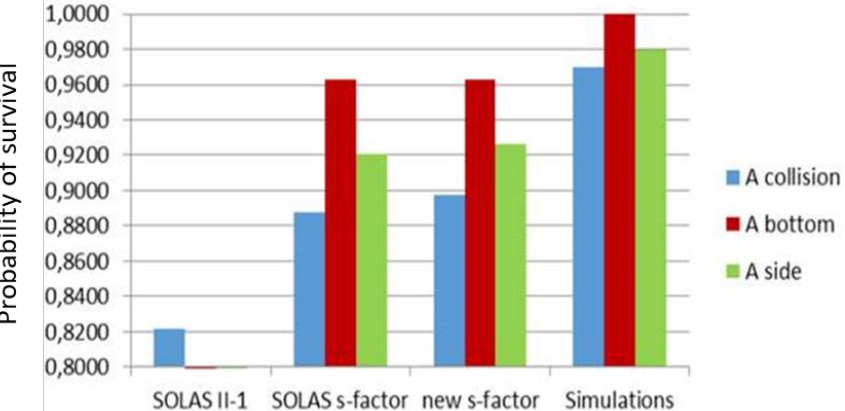
Figure 6. Comparison between static and dynamic assessment—Ship A.